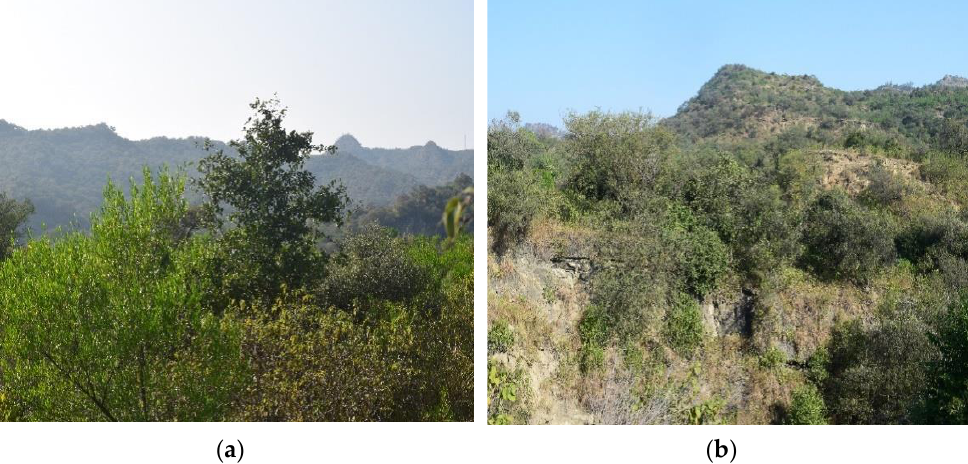
Figure 1. Topography of the study area showing rugged and steep mountains (b) and dry scrub vegetation (a).